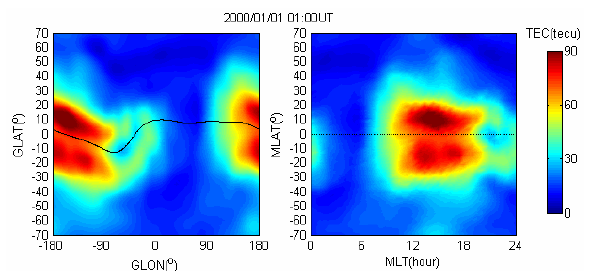
Figure 1. An example of GIM being transformed from an earth-fixed Fig. 1. An example of GIM being transformed from an Earth-fixed geographic frame into a MLAT-MLT frame at 01:00 UT of 2000/01/01. geographic frame into a MLAT-MLT frame at 01:00 UT on 1 Jan- uary 2000.